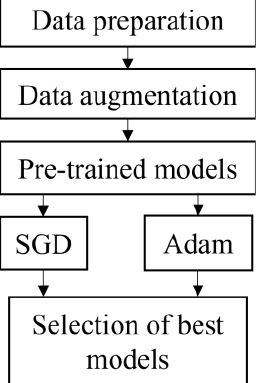
Figure 1. Flowchart of classification models.